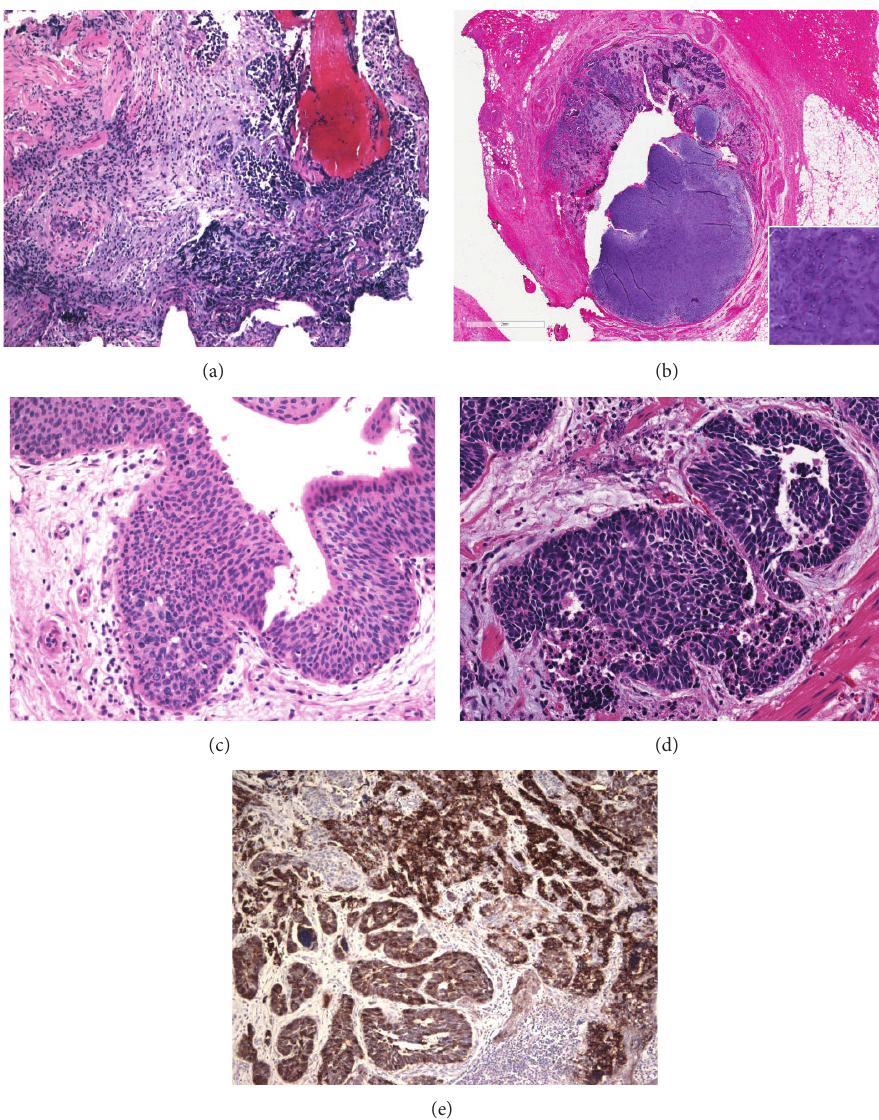
Figure 1: Histologic appearance of carcinosarcoma of the ureter. (a) Biopsy demonstrating poorly differentiated, dark blue cell tumor with marked crush artifact (5x, H&E). (b) Ureterectomy specimen demonstrating tumor obliterating the ureter lumen with high grade chondrosarcoma component (5x and insert 20x, H&E). (c) Ureter with urothelial carcinoma in situ (20x, H&E). (d, e) Small cell carcinoma component in carcinosarcoma showing strong and diffuse immunoreactivity with CD56 (e) (20x, H&E and 10x,